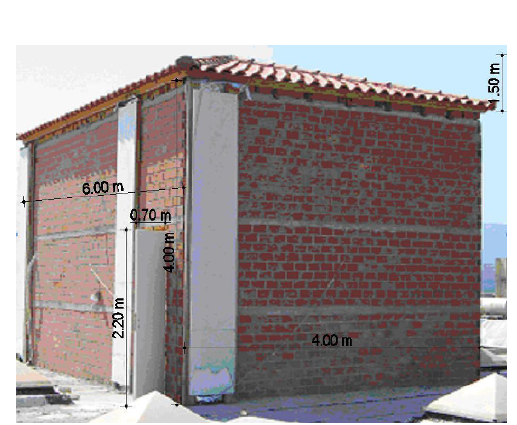
Figure 1. View of the test chamber outside.